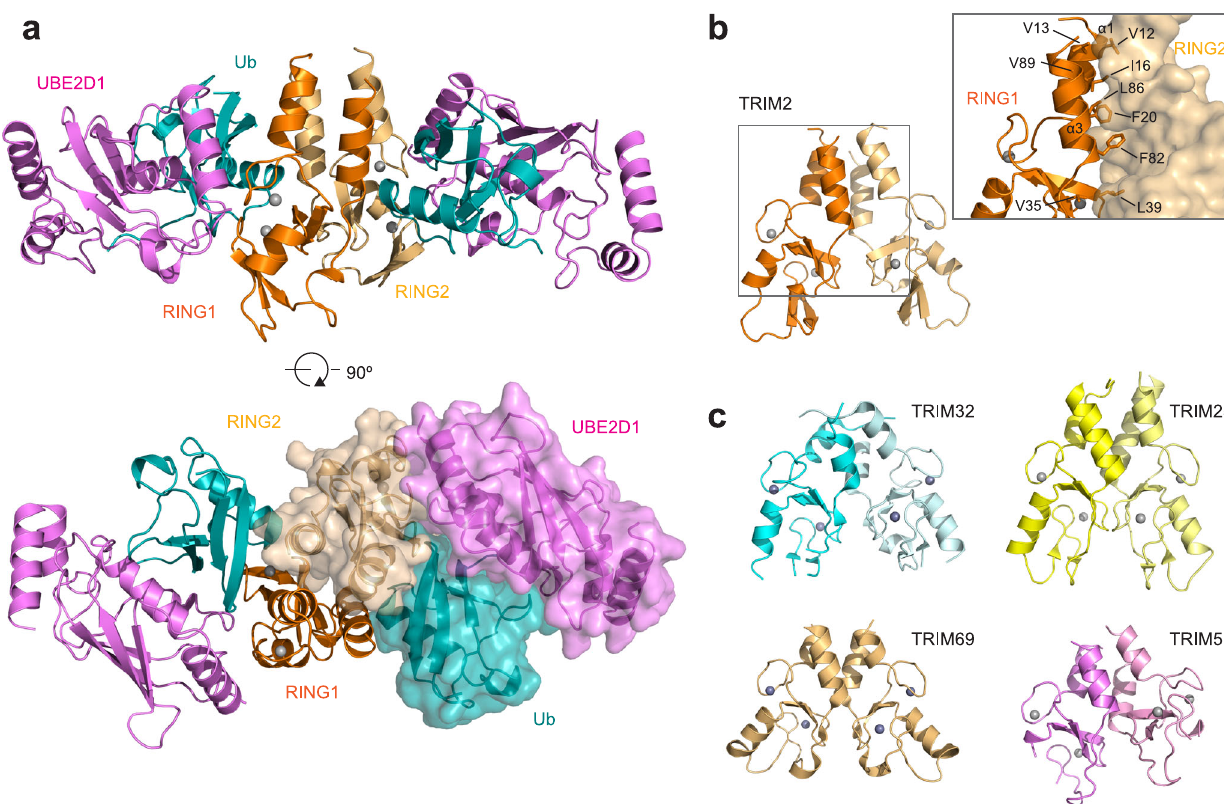
Fig. 2 | Crystal structure of TRIM2 RING in complex with the UBE2D1~Ub con- jugate.a CartoonrepresentationofthecrystalstructureofthehomodimericRING of TRIM2 bound to twoUBE2D1~Ubconjugates. The bottom panelisrelatedto the upper one by a 90° rotation about the x -axis and shows one RING, E2 and Ub in surfacerepresentation.TheRINGdomainsarereportedinorange(RING1)andlight